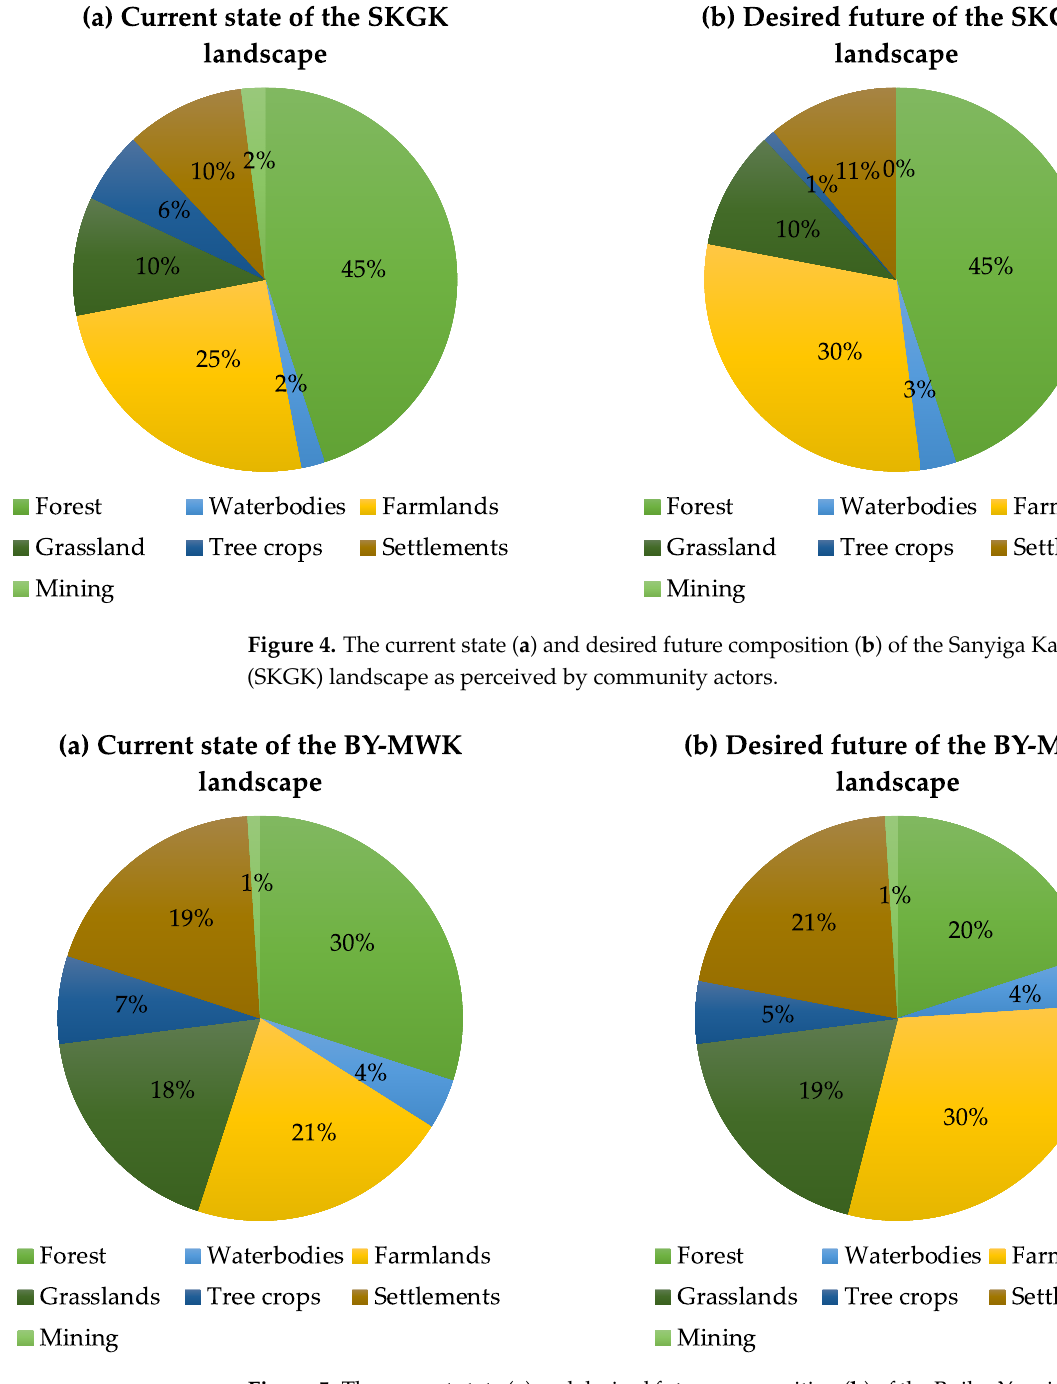
Figure 5. The current state ( a ) and desired future composition ( b ) of the Builsa Yenning (BY)-Moagduri Wuntanluri Kuwomsaasi (MWK) landscape as perceived by community actors.